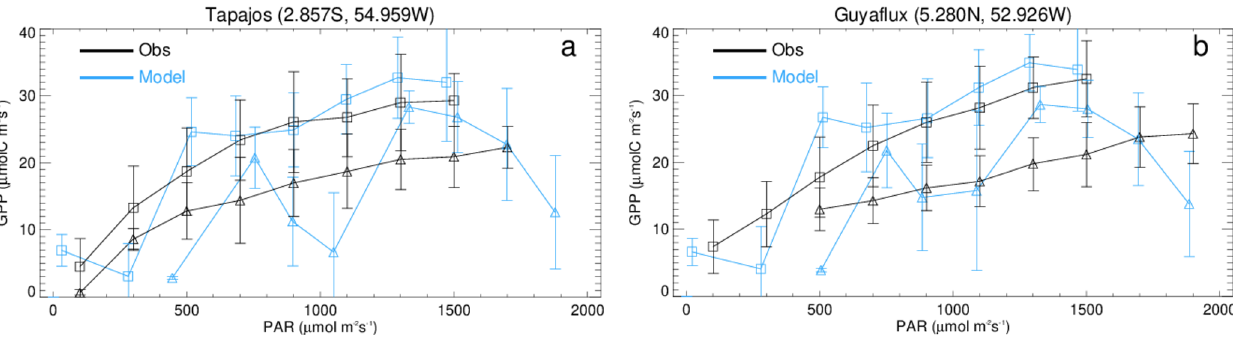
Figure 8. Observed (black) and GEOS modeled (blue) response of GPP to direct (triangles) and diffuse (squares) photosynthetically active radiation (PAR) averaged over bins of 200µmol quanta m 2 s − 1 at (a) Tapajos and (b) Guyaflux. Error bars show 1 standard deviation of all values within a bin. The observation data, representing the period 2002–2005 for Tapajos and 2006–2007 for Guyaflux, are taken from Fig. 2 of Rap et al. (2015), whereas the model period is 2010–2016 for both